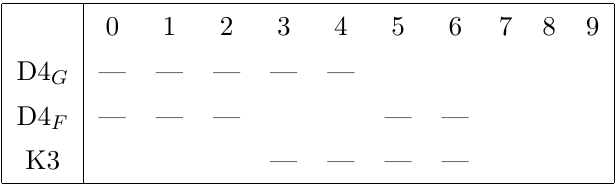
— — — — Table 1. IIA realization. The gauge branes wrap exceptional curves (along x 3 , x 4 ), and the flavor branes wrap copies of C (along x 5 , x 6